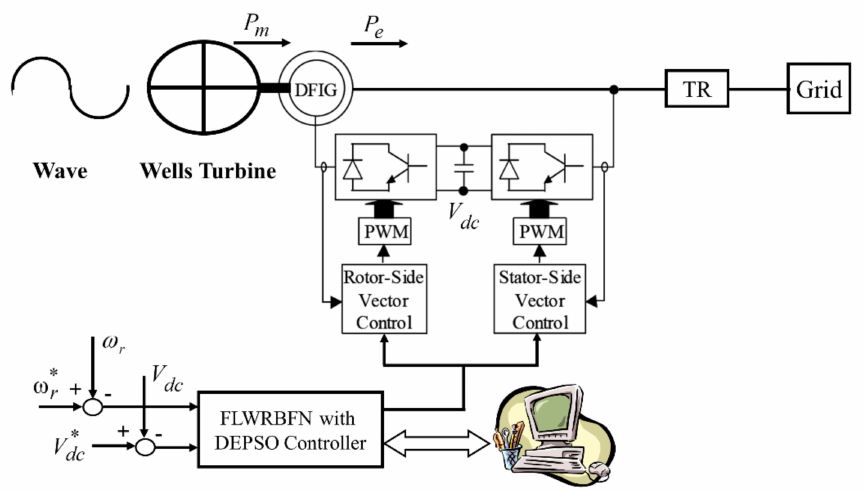
Figure 1. Schematic of a DFIG-based Wells turbine